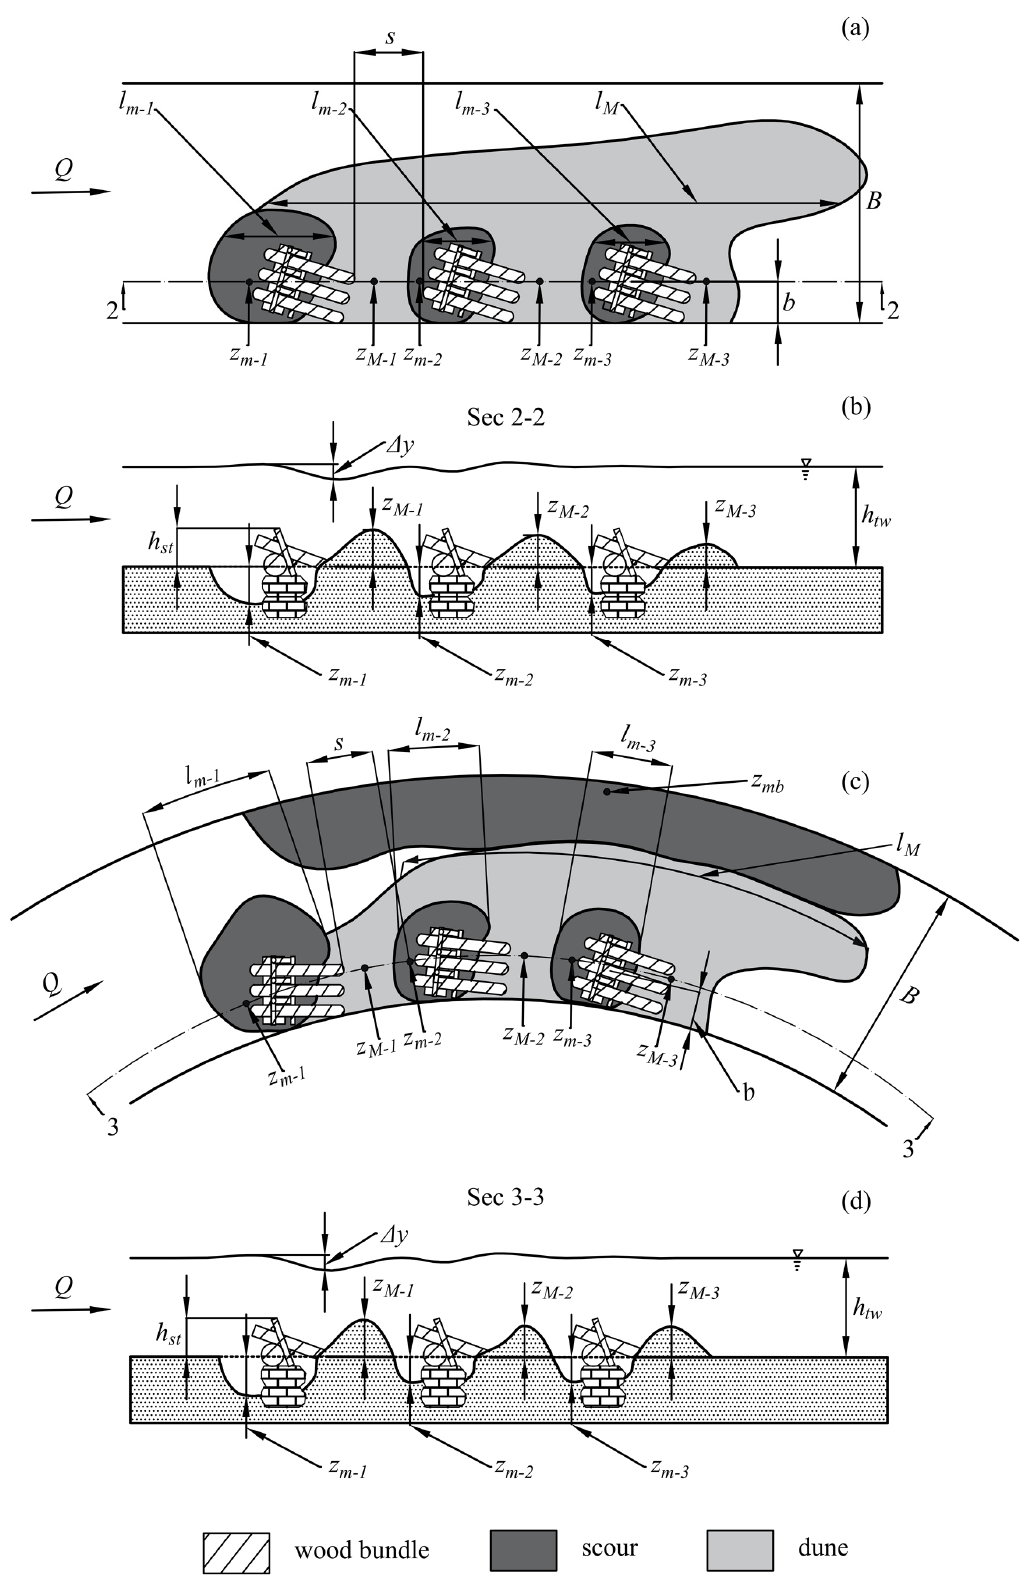
Figure 2. ( a ) Plan and ( b ) cross-sectional views of the wood bundle structure series along with important hydraulic and scour parameters in the case of straight channels; ( c ) plan and ( d ) cross-sectional views of the wood bundle structure series in the case of curved channels.